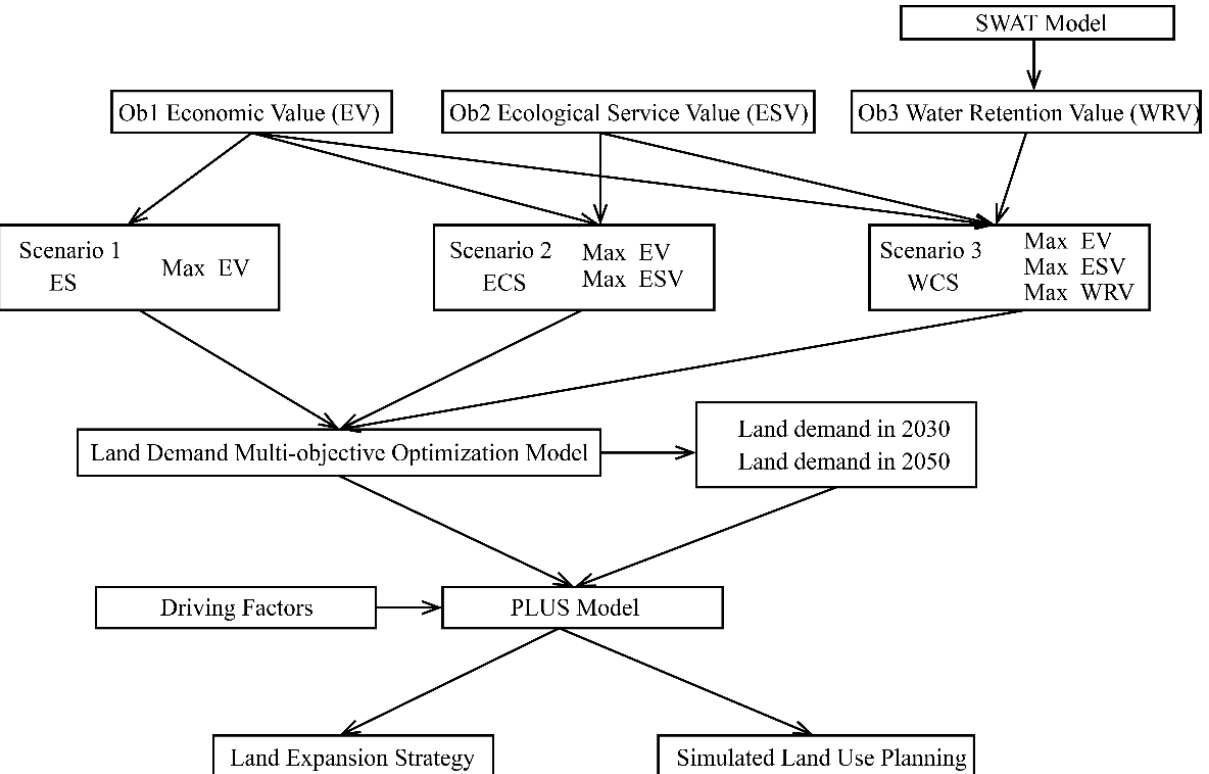
Figure 1. Land use planning framework and flow chart.